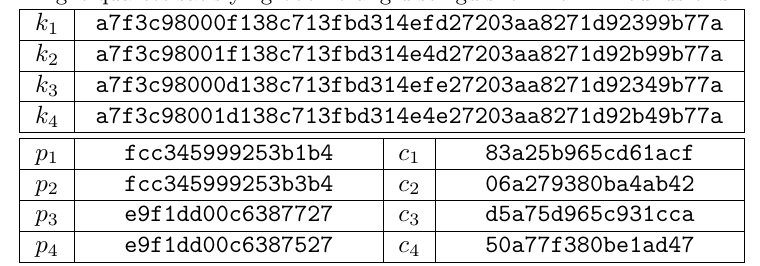
Table 23: A right quartet satisfying boomerang distinguisher I for 22 rounds of SKINNY -64-192